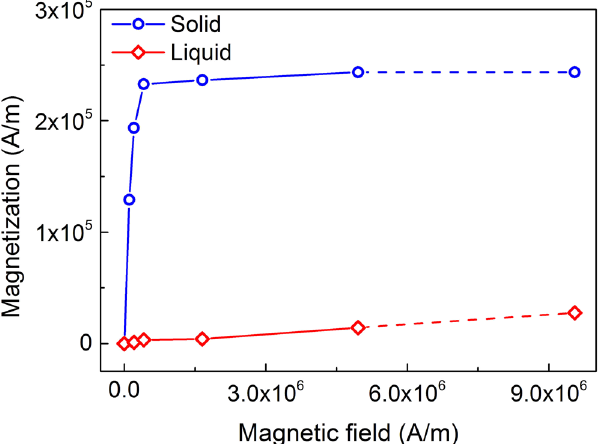
Figure 7. The magnetization of Co 76 Sn 24 during heating (in solid state) and cooling (in uncercooled liquid state) at 1152 ± 2 K under different external